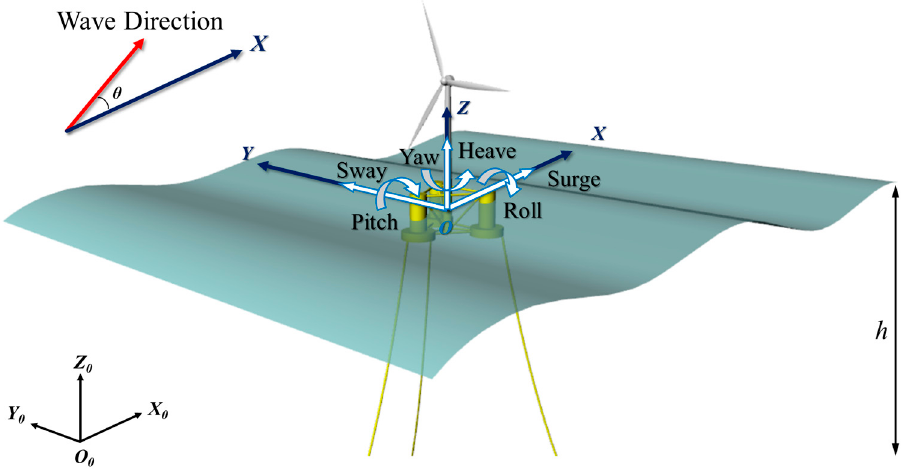
Figure 2. The diagrams of earth-fixed (O 0 -X 0 Y 0 Z 0 ) and body-fixed (O-XYZ) coordinate systems.